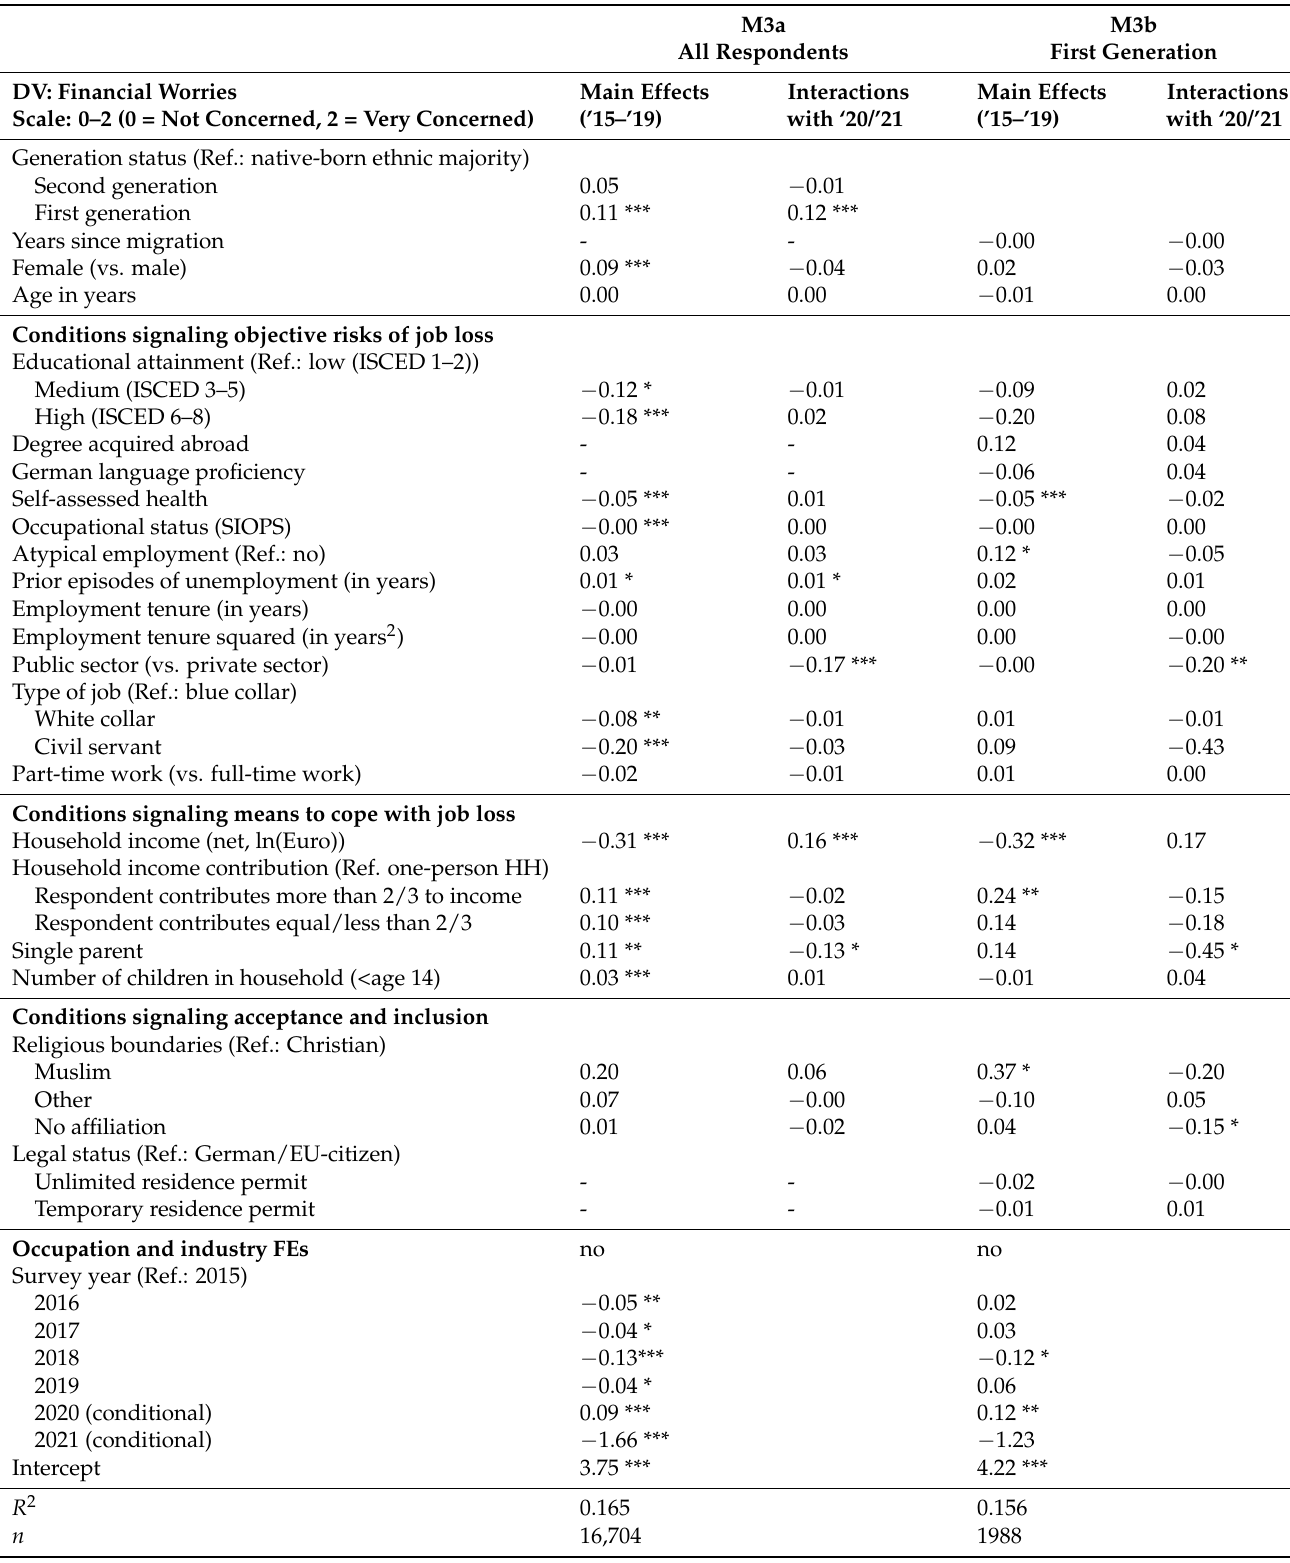
Table A4. Linear regression, financial worries, 2015 to 2021.